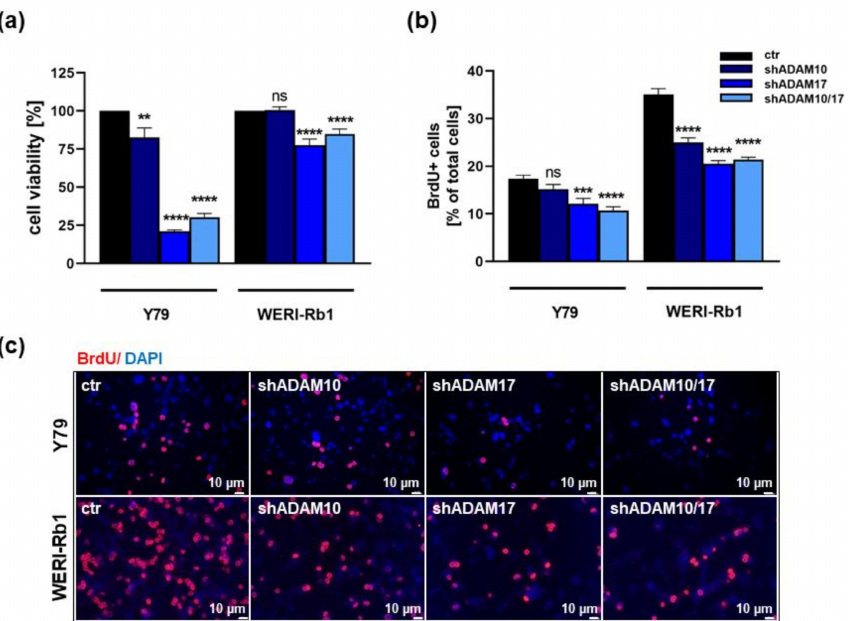
Figure 2. Verification of ADAM10 and ADAM17 knockdown efficiency. Efficient stable, lentiviral ADAM10 (shADAM10), ADAM17 (shADAM17) and ADAM10/17 (shADAM10/17) double knock- down was verified by quantitative real-time PCR ( a , d ) and western blot analyses in Y79 ( b , c ) and WERI-Rb1 cells ( e , f ). Indicated intensity ratios relative to ß-actin, used as a loading control, were cal- culated using MICRO MANAGER 1.4 software. Values are means of three independent experiments ± SEM. *** p < 0.001 and **** p < 0.0001 statistical differences compared to the control (ctr) group calculated by Student’s t -test.